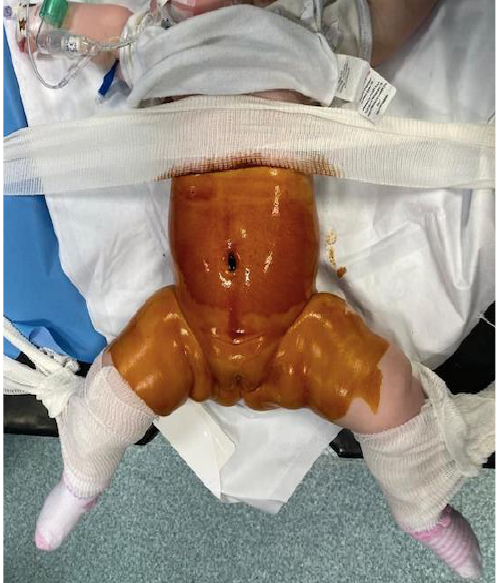
Figure 3. Intraoperative image: Patient decubitus.